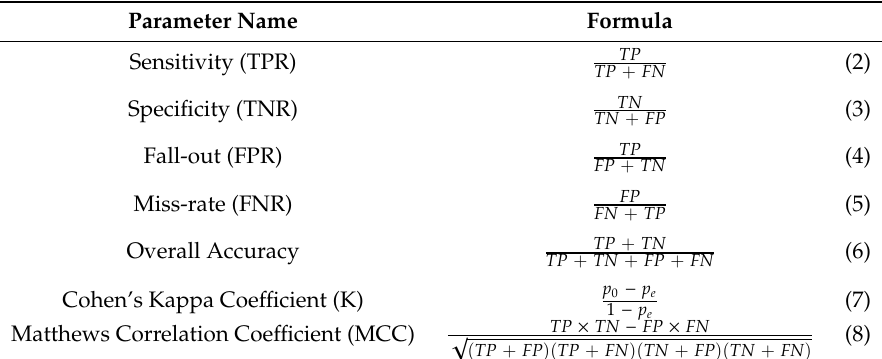
Table 2. Formulas related to accuracy assessment